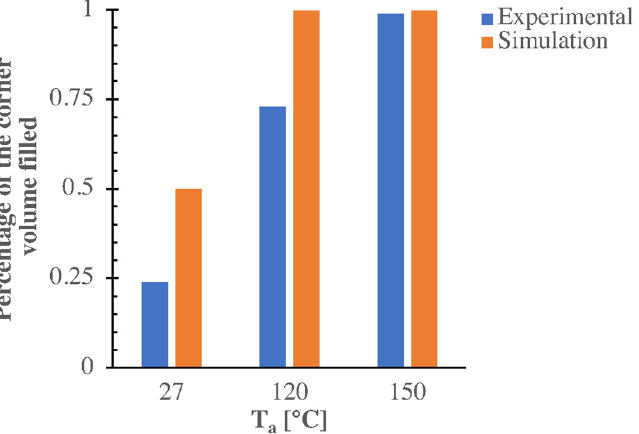
Figure 14. Experimental and calculated percentage of the corner volume filled for the three molding conditions considered in this work.